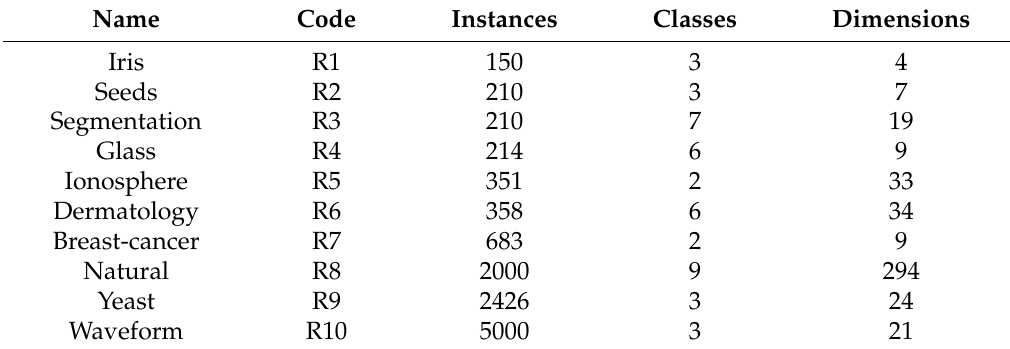
Table 2. The ten UCI datasets used.